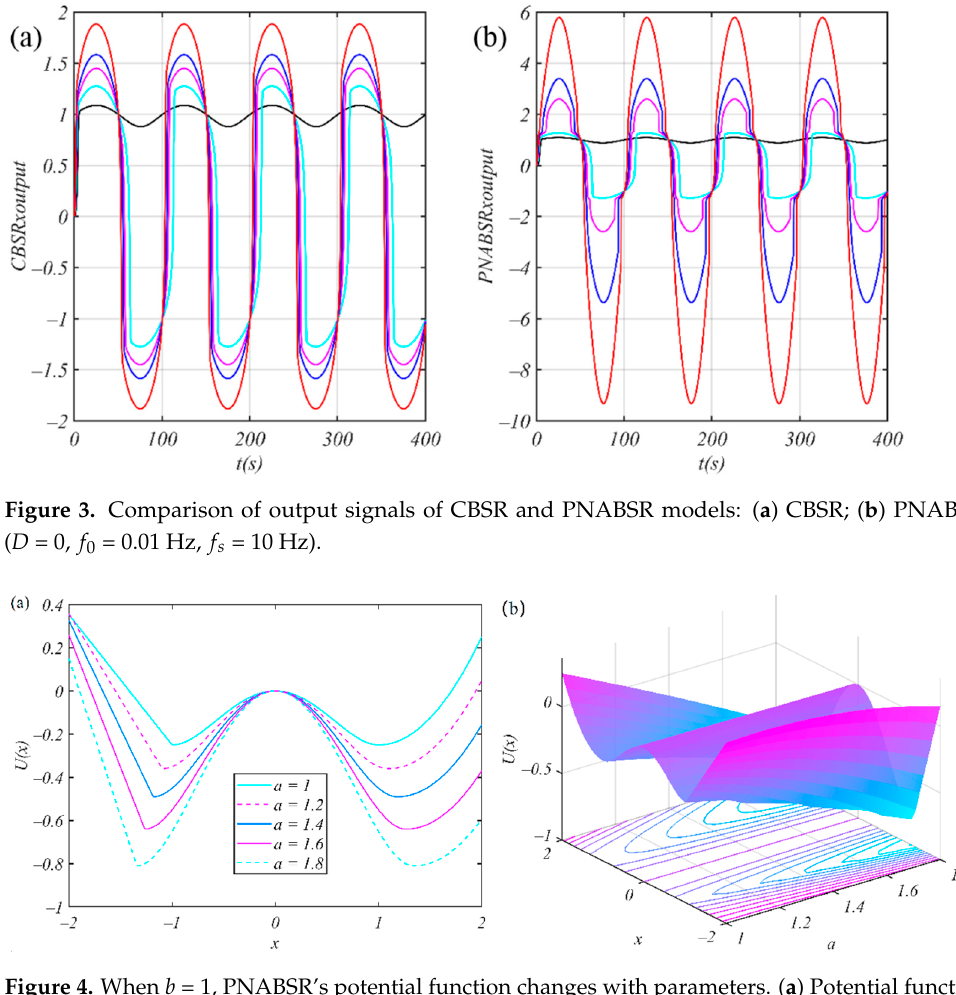
Figure 4. When b = 1, PNABSR’s potential function changes with parameters. ( a ) Potential function changes with a ; ( b ) Potential function changes with a and x